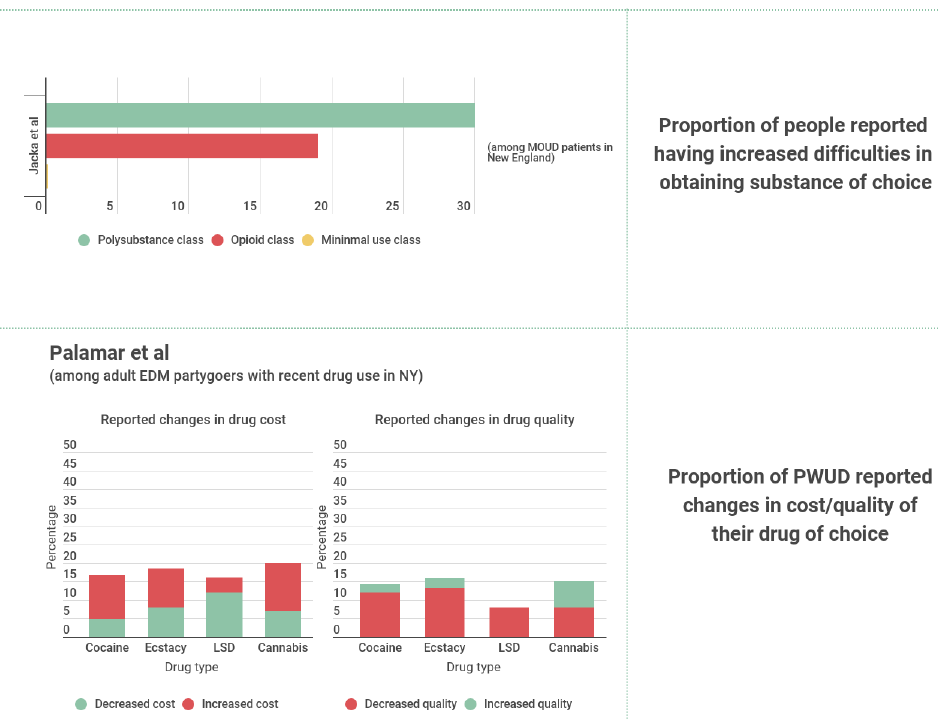
Figure 5. Summary evidence for illicit drug market changes. MOUD= Medications for Opioid Use Disorders. LSD = Lysergic Acid Diethylamide. EDM = Electronic Dance Music. NY = New York [25,34].